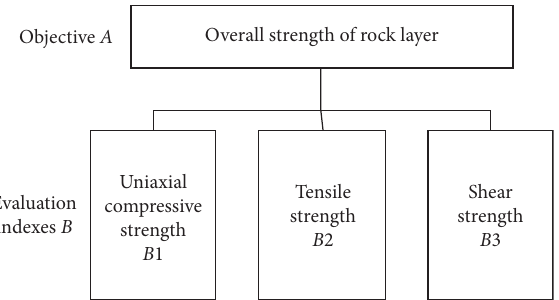
Figure 4: Hierarchy diagram of stratum overall strength. Figure 5: Weight value histogram of each evaluation index of the overall strength of stratum.